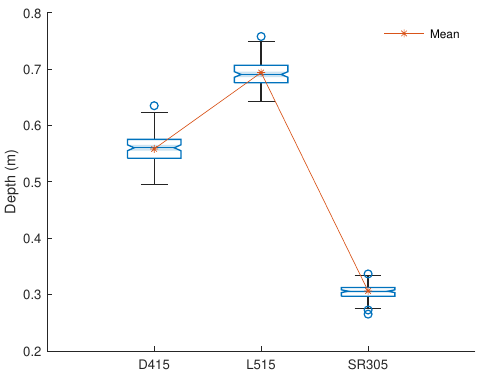
Figure 12. Normal Distributions - Water full